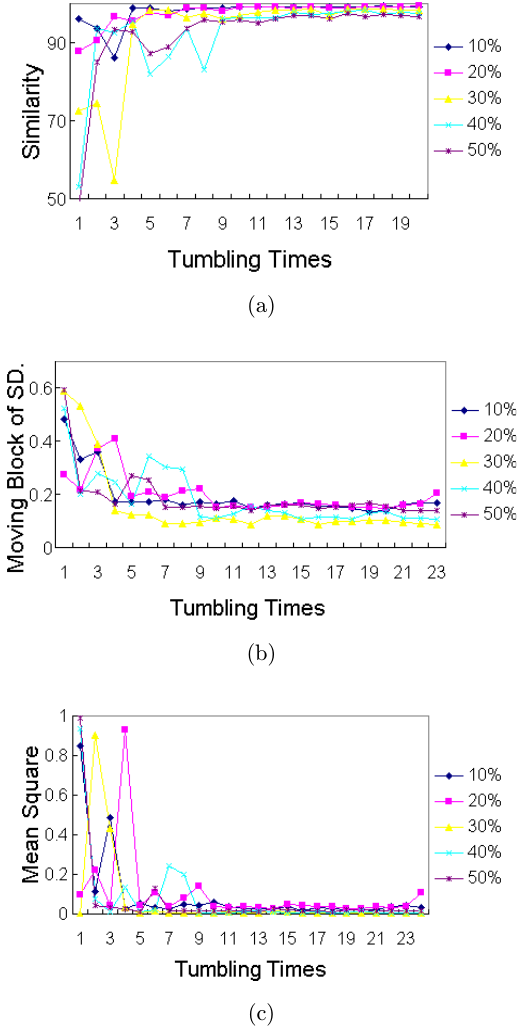
Fig. 4. Similarity (a), moving block values (b) and mean square (c) pro¯les of all batches at di®erent coptis contents as a function of tumbling